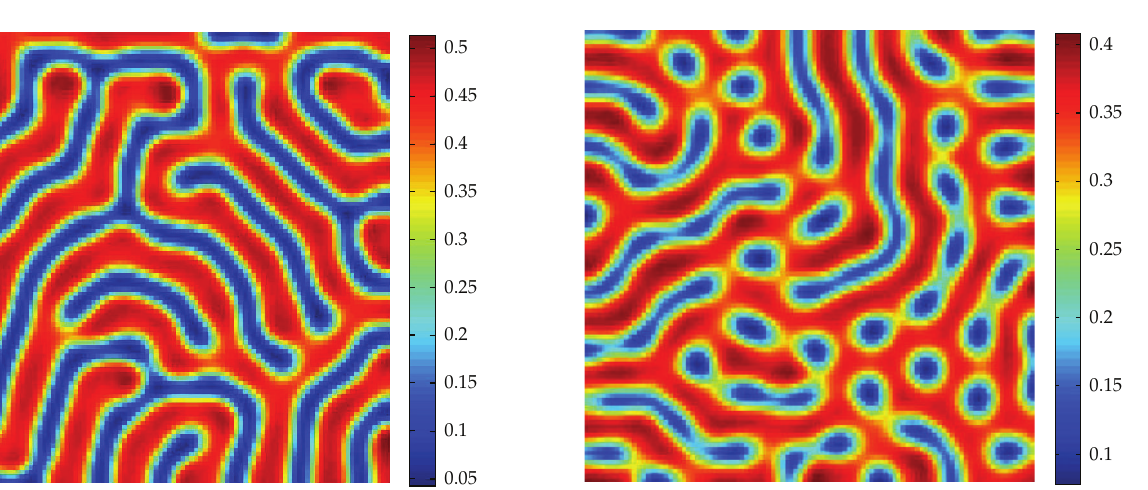
Figure 9: Stripes pattern of 𝐻 in model (8) for 𝑚 = 0.78 at 𝑡 = 1000 . Figure 10: Spot-stripe mixtures pattern of